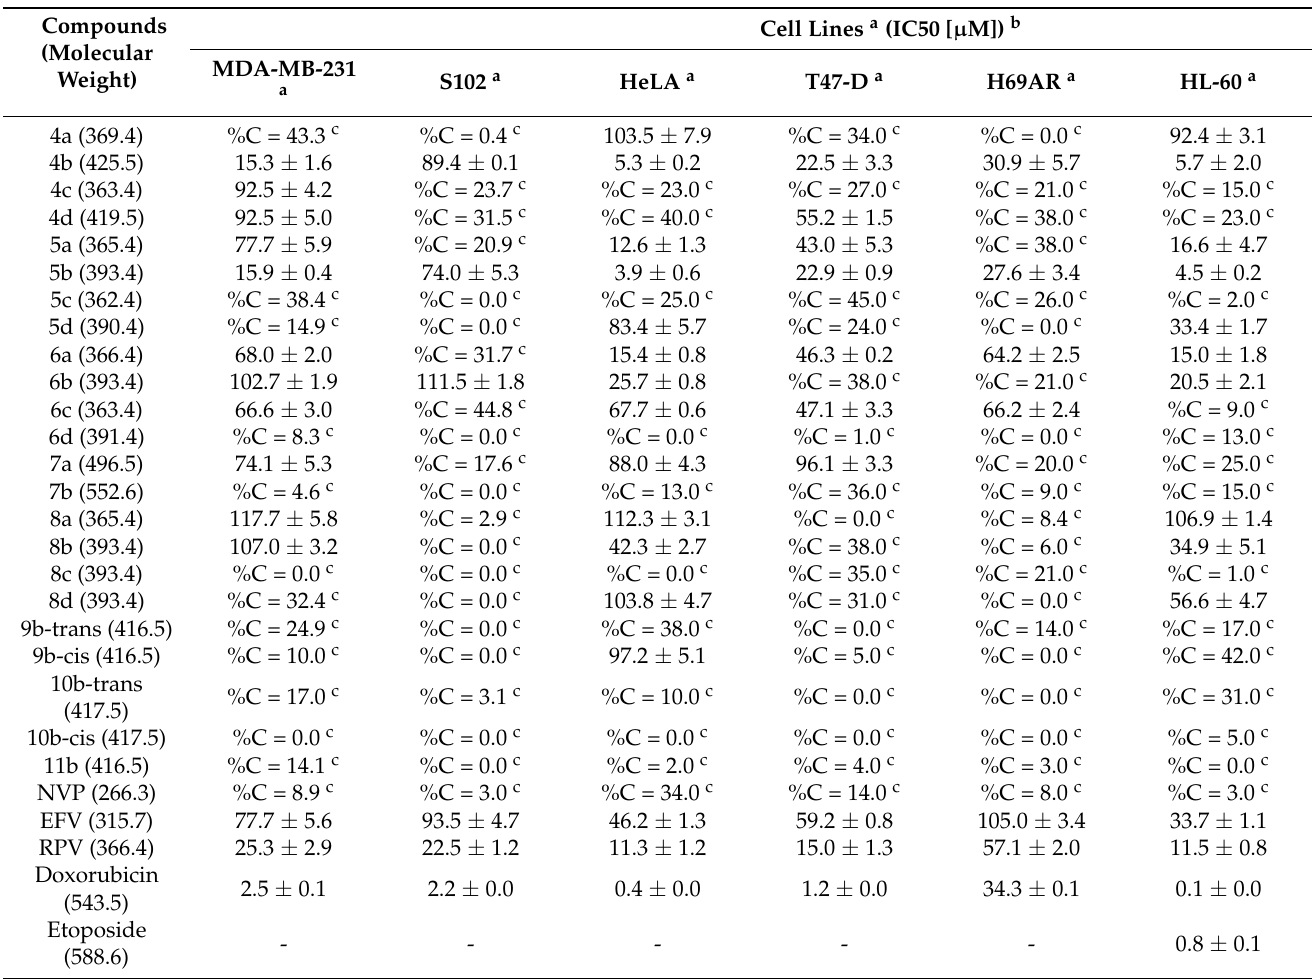
Table 5. In vitro cytotoxicity of the derivatives and commercially available drugs to human cancer cell